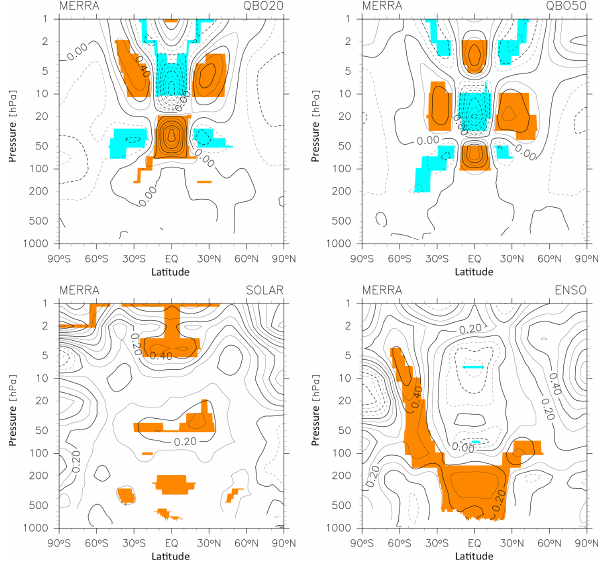
Figure 2. As in Fig. 1 but for MERRA reanalysis data.